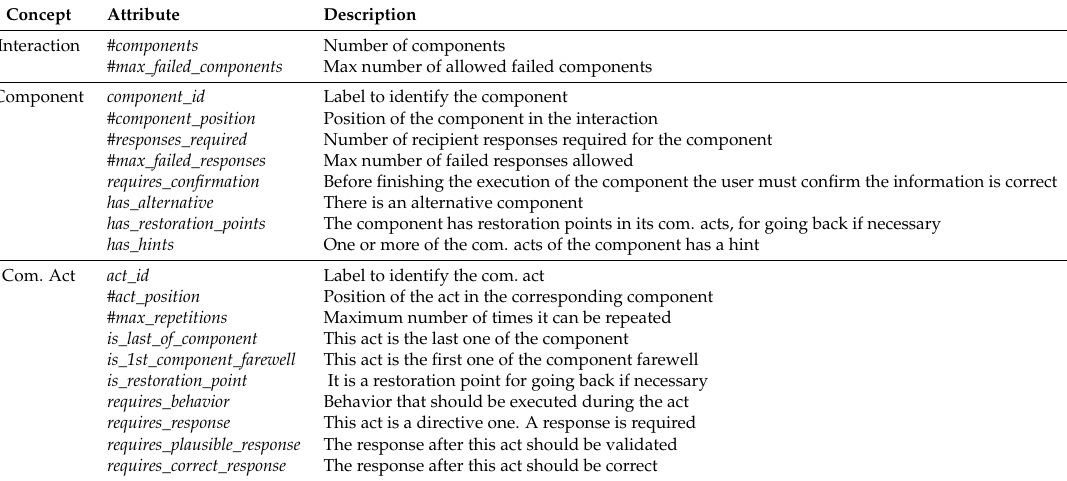
Table 1. Description of definition attributes.